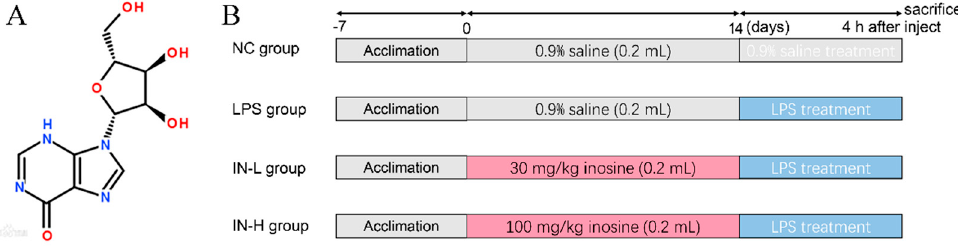
Figure 1. The structure of inosine ( A ); the experimental schedule ( B